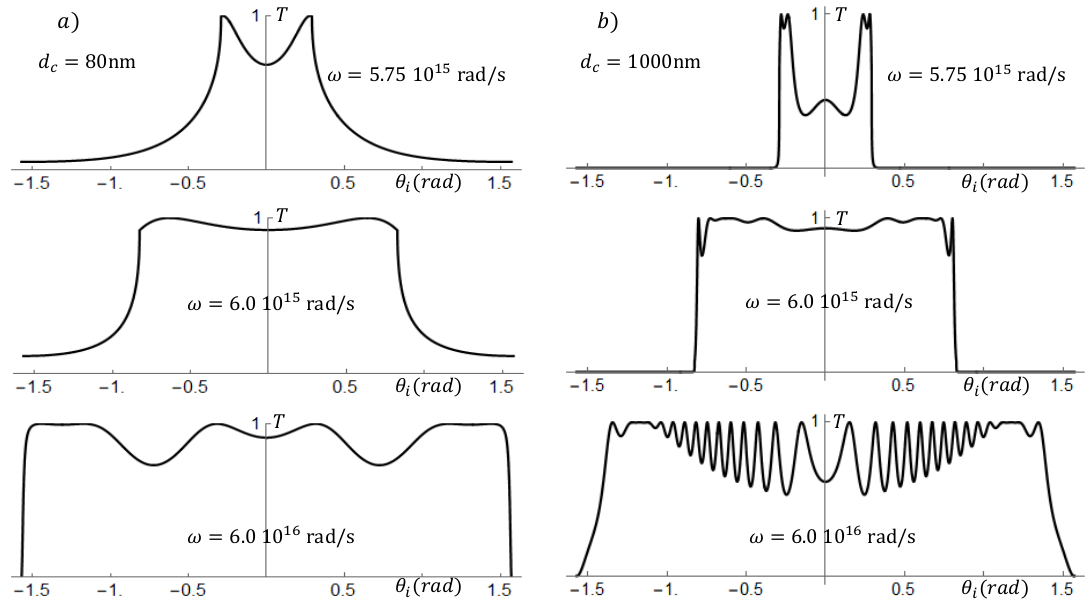
Figure 3. Transmittance through a single slab as a function of the incidence angle θ i , for three different EM frequencies. For the graphs in the ( a ), the silver slab thickness is d c = 80 nm, and in the ( b ), d c = 1000 nm. Notice that the number of oscillations at high frequencies is of the order of d c / λ